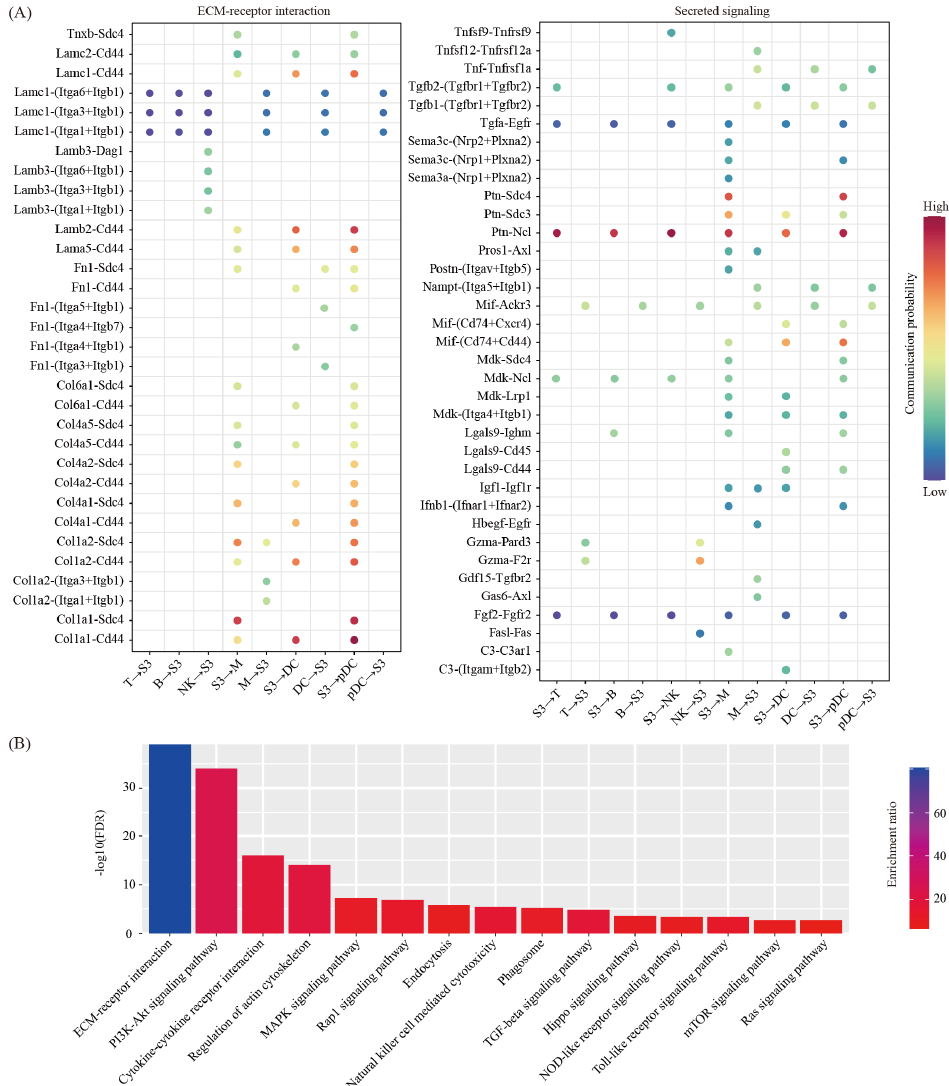
Figure 5. Cell–cell communication between decidual cells and immune cells. ( A ) Dot plot showing selected ligand-receptor interactions underlying crosstalk between decidual cells (S3) and immune cells (T, NK, B, M, DC and pDC). The communication probability defined by the CellChat software were indicated by color. ( B ) KEGG pathway enrichment analysis of ligand-receptor pairs by using Metascape online tools.